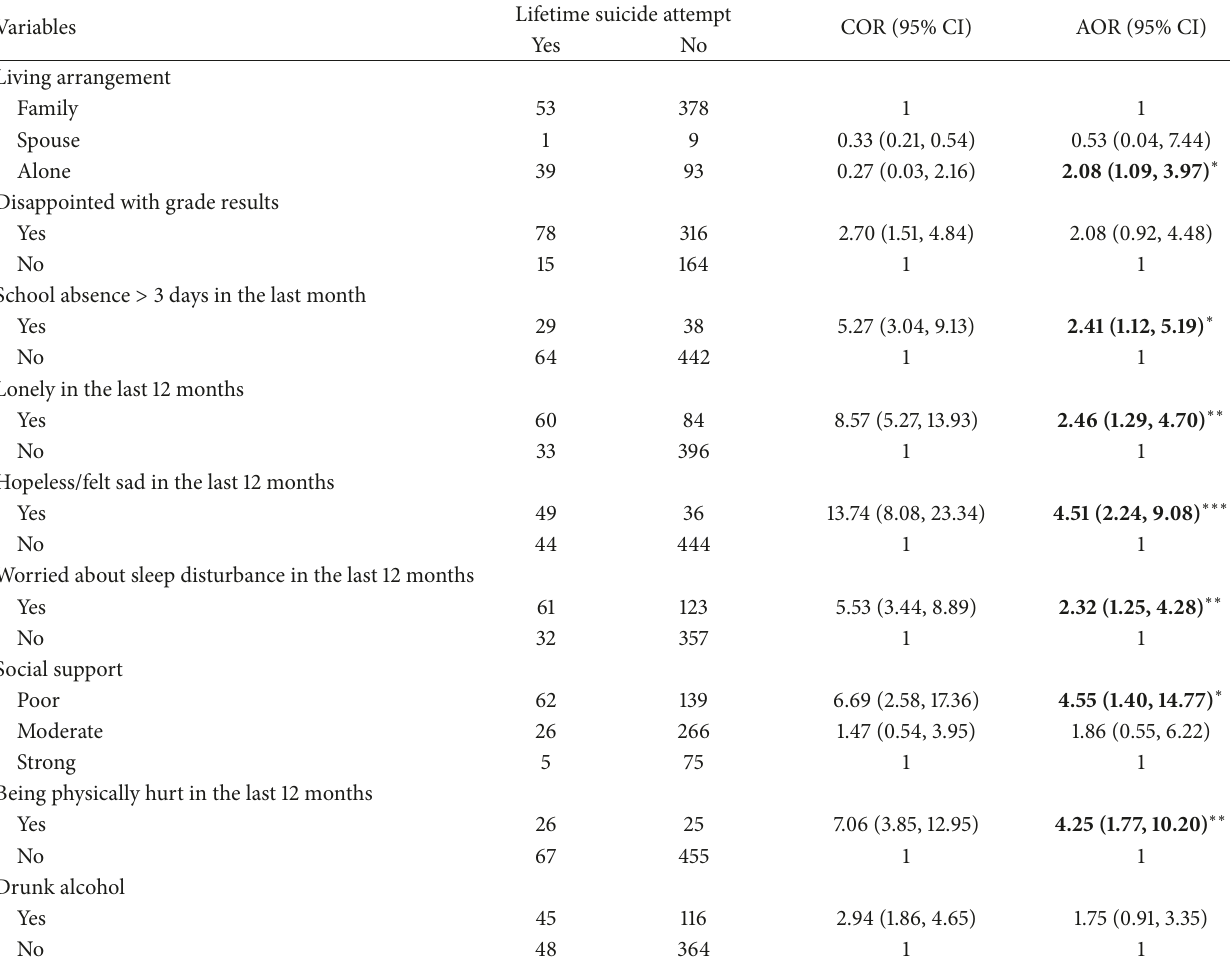
Table 6: The bivariable and multivariable logistic regression analysis results of suicide attempt and associated factors among adolescent high school students in Dangila Town, Northwest Ethiopia,